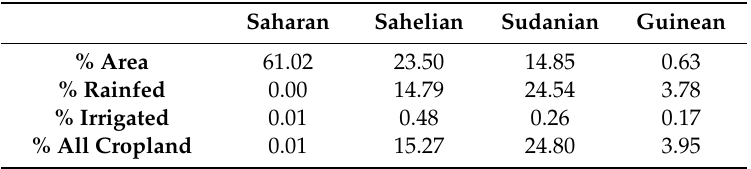
Table 5. Proportion of area and cropland by climatic zones in our study domain including Senegal, Mauritania, Mali, Burkina Faso, and